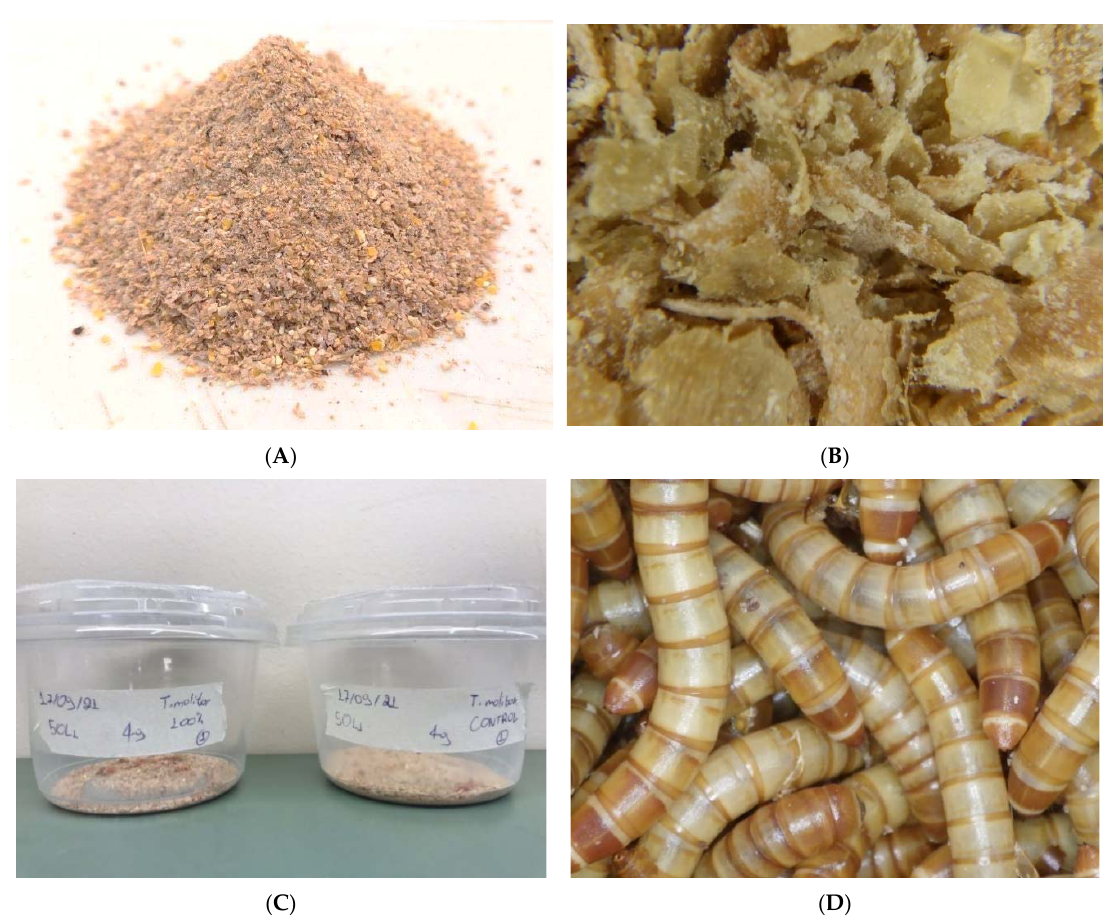
Figure 2. Representative illustration of milled whole carob pods ( A ) and substrate with 50% milled carob ( B ) used for rearing ( C ) in transparent plastic cylindrical vials (7.5 cm in diameter, 8.8 cm in height) containing Tebebrio molitor larvae ( D